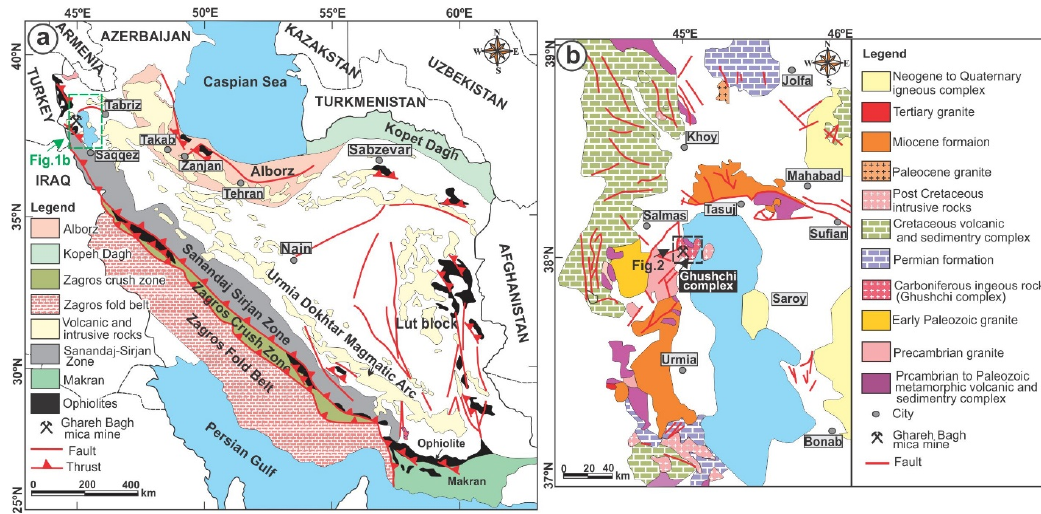
Figure 1. ( a ) The structural geological map of Iran [38]. The Ghareh Bagh mica mine is located in the northern Sanandaj-Sirjan Zone (SaSZ). ( b ) Simplified geological map of NW Iran [39,40].